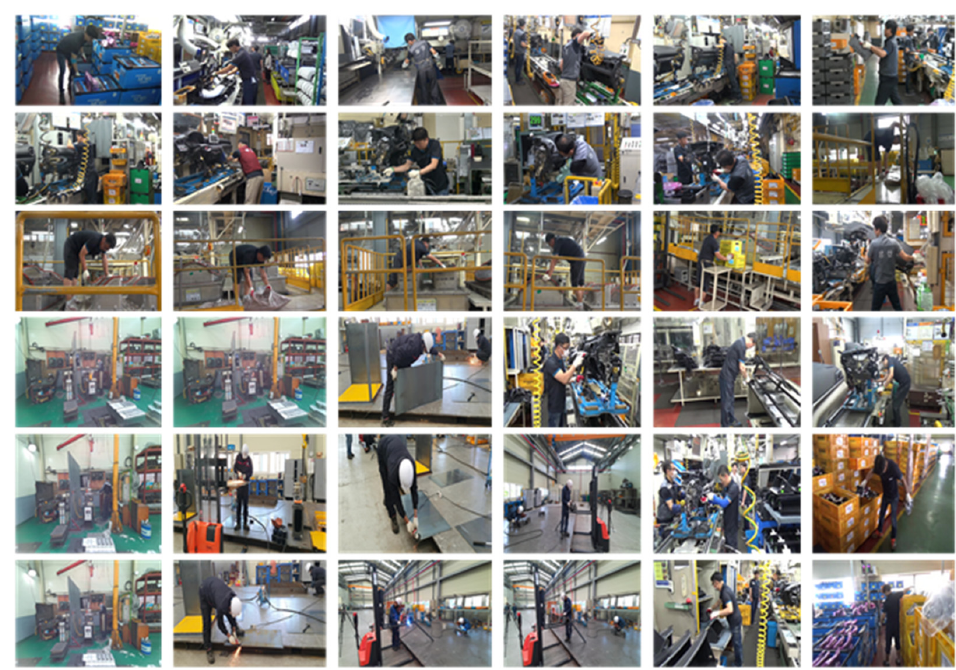
Figure 4. Sample images of workers’ different working poses.